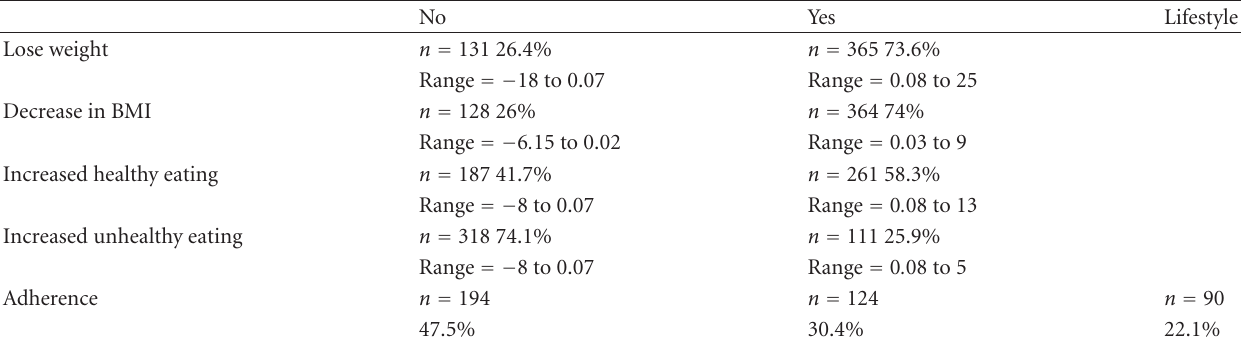
Table 2: Descriptive analysis of baseline to 6 months